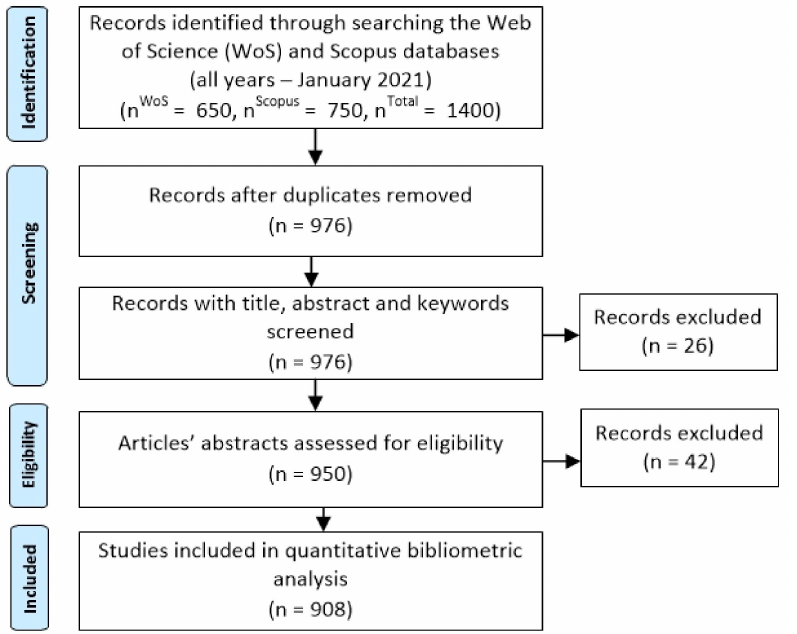
Figure 1. The PRISMA flow